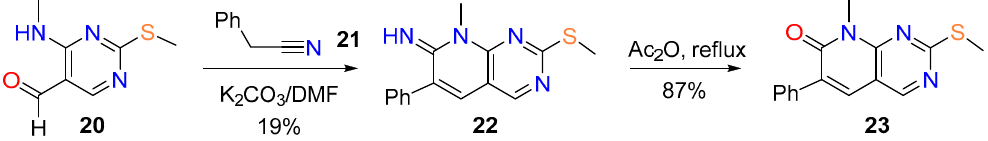
Figure 11. Synthesis of the pyrido[2,3- d ]pyrimidin-7(8 H )-one ( 23 ) from pyrimidine aldehyde ( 20 ).